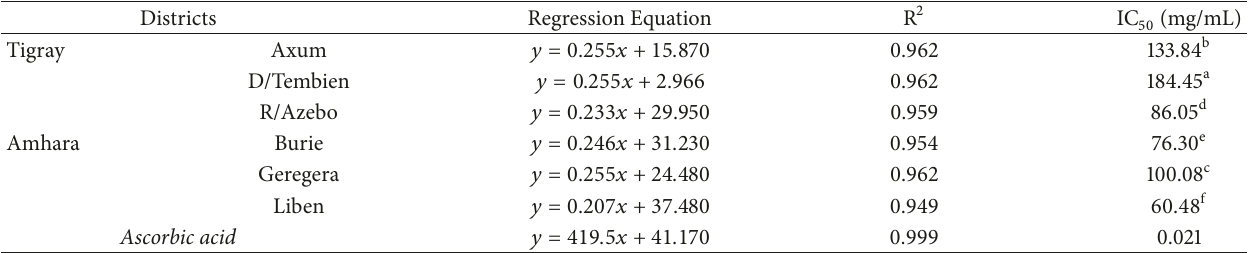
Table 3: Antioxidant activity of honey samples in terms of their IC 50 values.